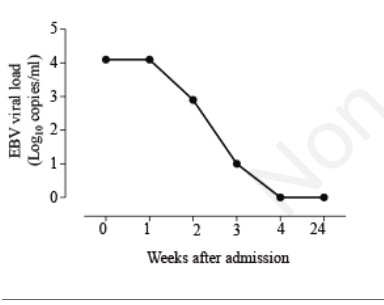
Figure 1. Changes of Epstein-Barr virus viral load following liposomal ampho- tericin B